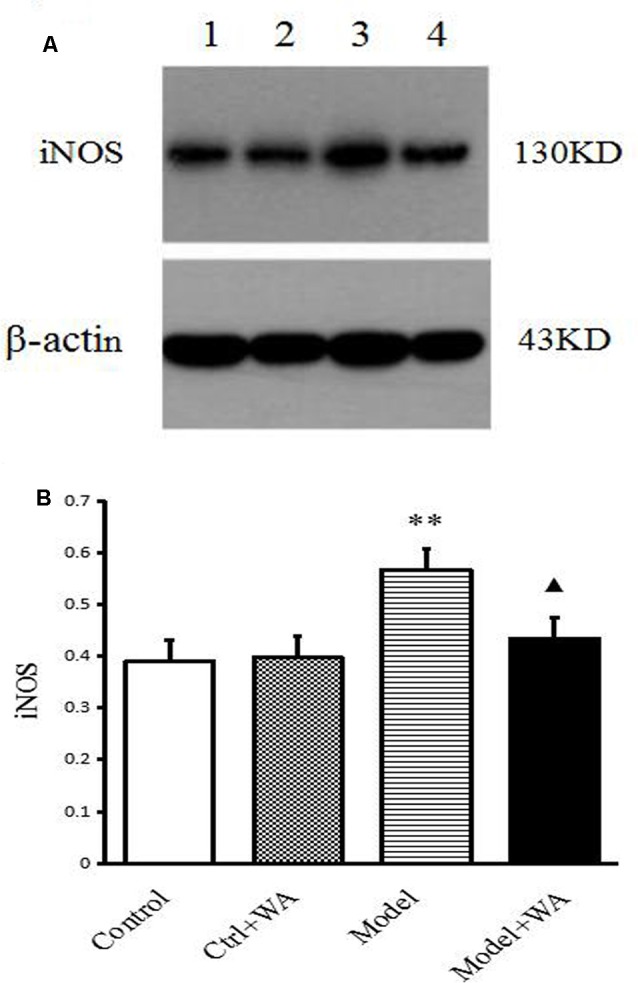
Effect of WA on iNOS expression in the hippocampus. (A) Representative immunoblots of iNOS and β-actin. 1. Control group; 2. Ctrl + WA group; 3. Model group; 4. Model + WA group. (B) Relative optical density (OD) of iNOS to β-actin. The data are presented as the means ± SD, n = 5 for each group. **P < 0.01; ▴P < 0.05 as compared with the Model group.